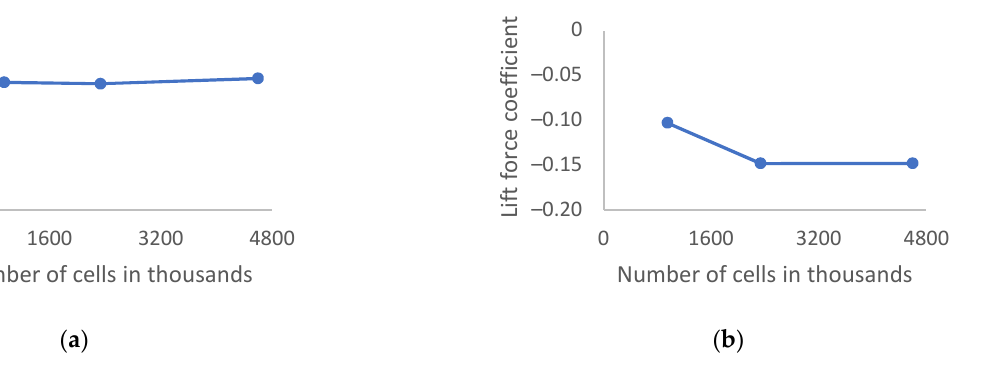
Figure 2. Values of ( a ) drag force coefficient and ( b ) lift force coefficient for different grid sizes used in calculations.